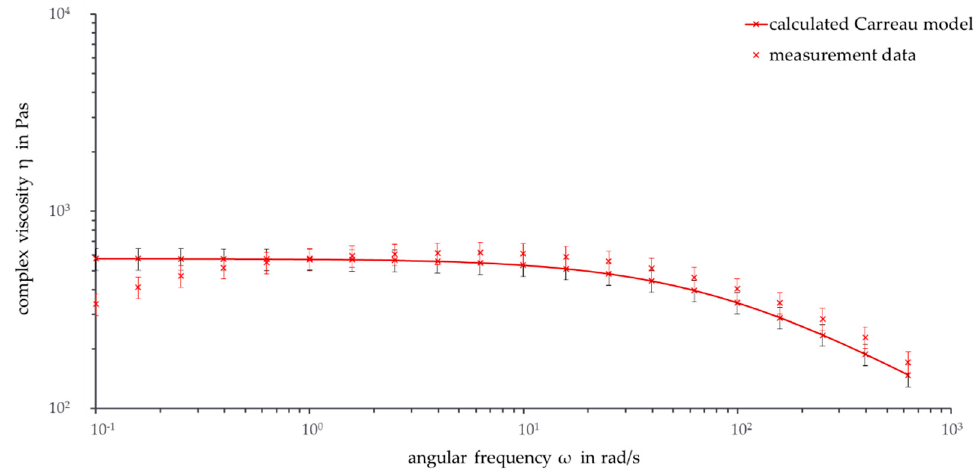
Figure 7. Frequency sweep: Calculated Carreau model and measurement data ( ϑ = 190 °C, ω = 0.1–628 rad/s).